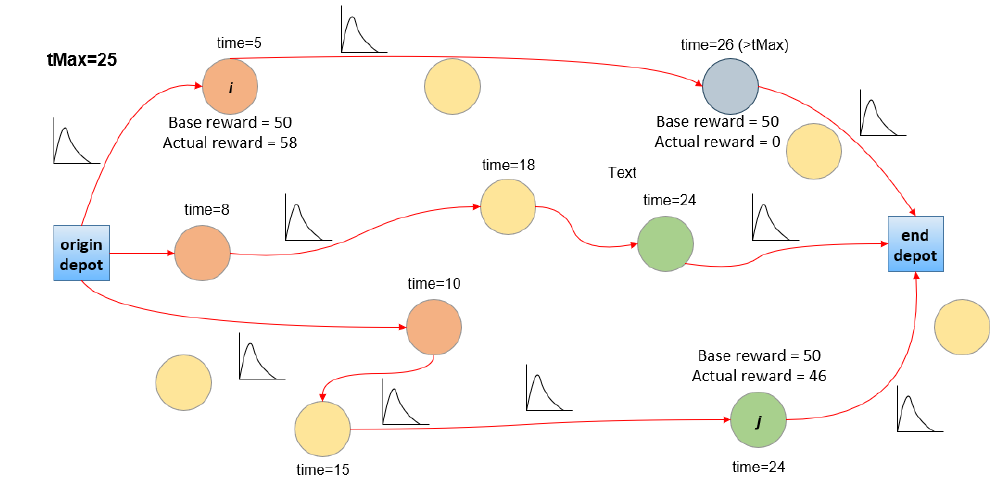
Figure 1. An illustrative example of the stochastic and position-dependent